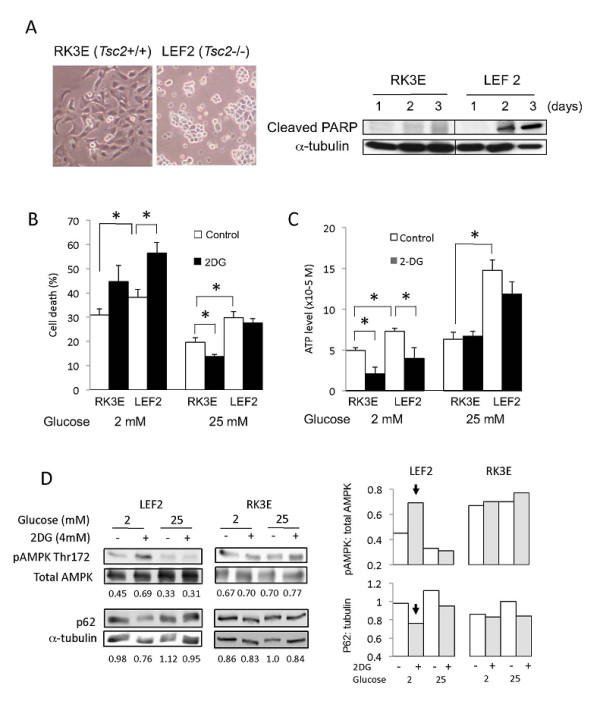
Effects of 2-DG on LEF2 cells. A) Wild-type RK3E and Tsc2-/- LEF2 cells were grown in 10%FBS DMEM with 2 mM glucose. Left: Phase contrast photomicrographs of cells after 2 days. Magnification 10×. Right: Immunoblot of cell lysates showing expression of cleaved PARP and α-tubulin at indicated times. Effects of glucose concentration and 2-DG (4 mM) for 6 hours on B) cell viability as determined by Annexin V/PI flow cytometric analyses, C) cellular ATP levels (Luminescence assay, PerkinElmer), error bars represent SEM. *, p < 0.05, and D) AMPK phosphorylation and p62 expression by Western blotting. The relative expression of these proteins were analyzed by densitometry, and the numbers under the blots indicate the ratio of band intensities (Image J) between p-AMPK:total AMPK and p62:α-tubulin. The densitometry results are also shown in graphical form on the right. Arrows indicate the most significant changes.